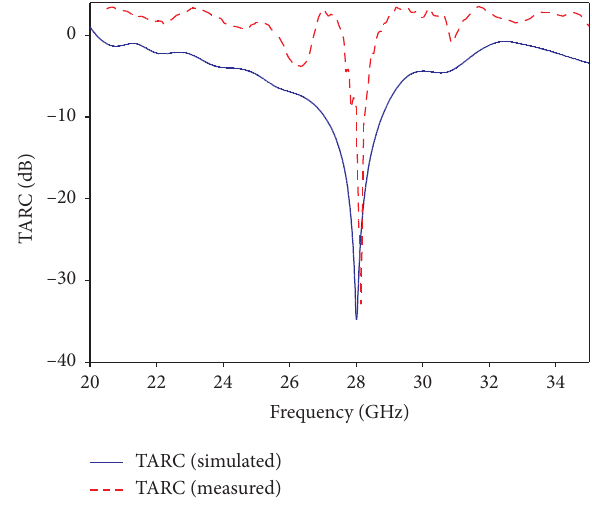
Figure 15: TARC of the proposed MIMO